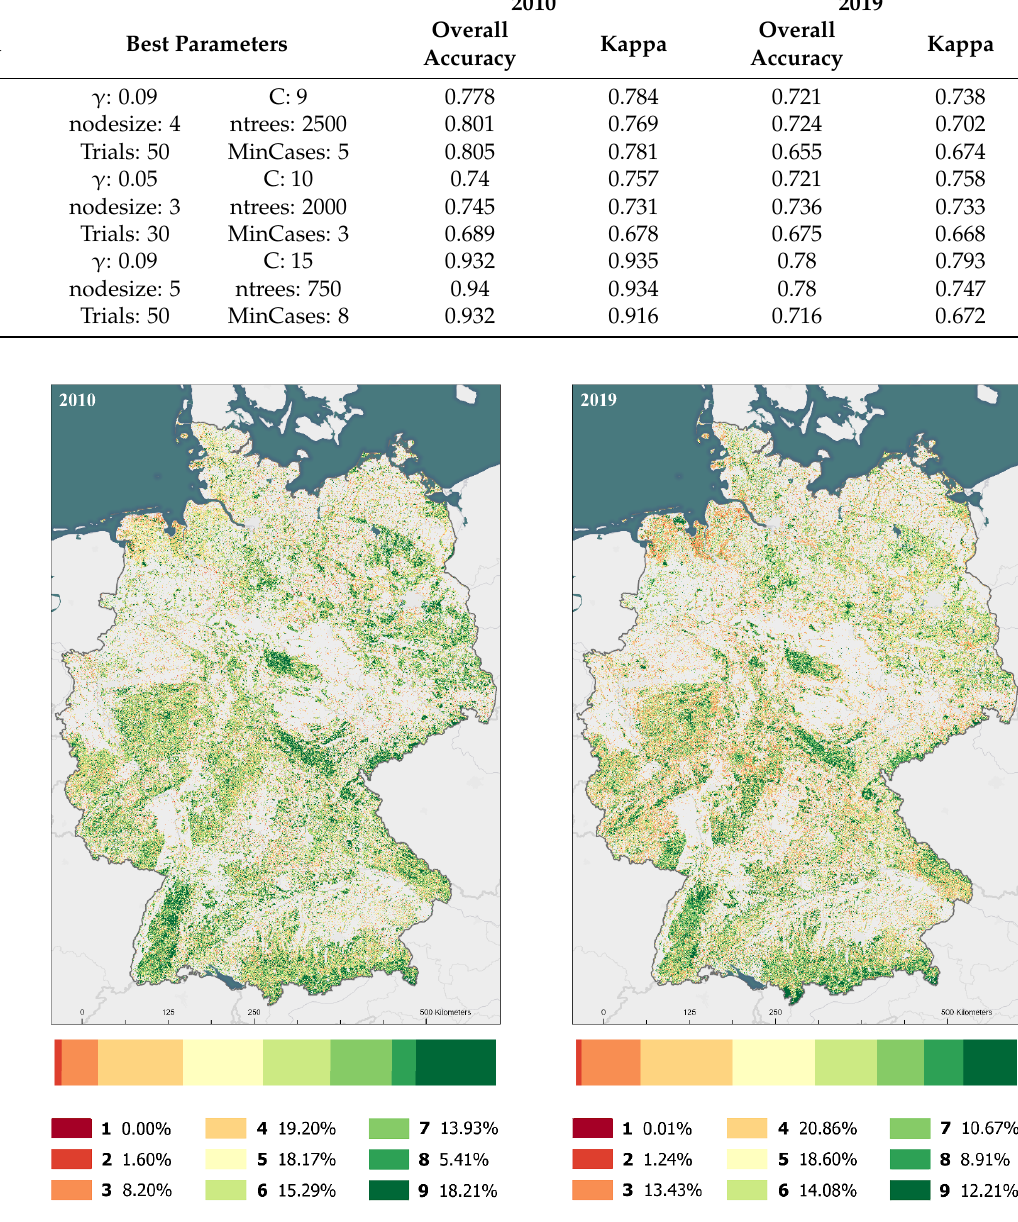
2019, with Galio ‐ Carpinetum oak ‐ hornbeam forests (F1 ‐ score 0.583) and Alluvial forests and riparian mixed forests (F1 ‐ score 0.431) being the least accurate. Both classes sometimes get misclassified as Asperulo ‐ fagetum beech forest ; Alluvial forests are also occasionally mistaken for Sub ‐ Atlantic oak ‐ hornbeam forests . Furthermore, Luzulo ‐ and Asperulo ‐ Fagetum beech forests are sometimes misclassified with each other. However, a more detailed report of the habitat type ‐ specific classification results in the confusion matrices (Appendix C) shows that most individual classes are only to a small extent confused with other classes.